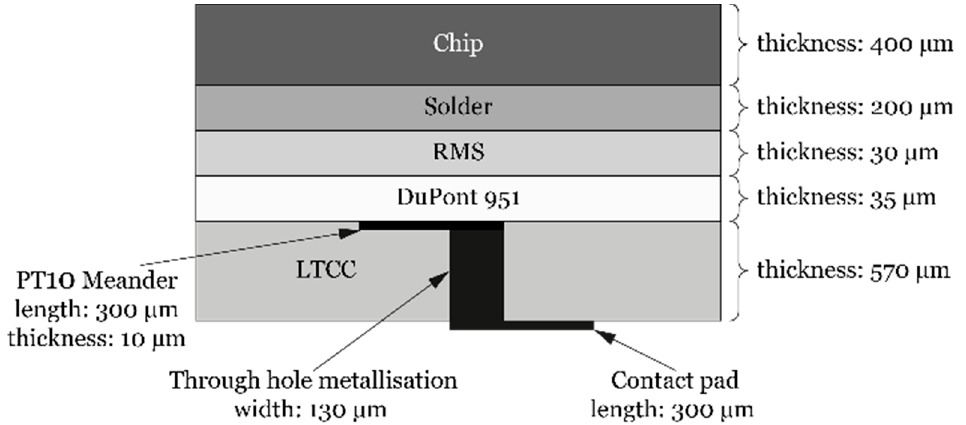
Figure 6. Dimensions of probes and layer thicknesses in x–z plane.